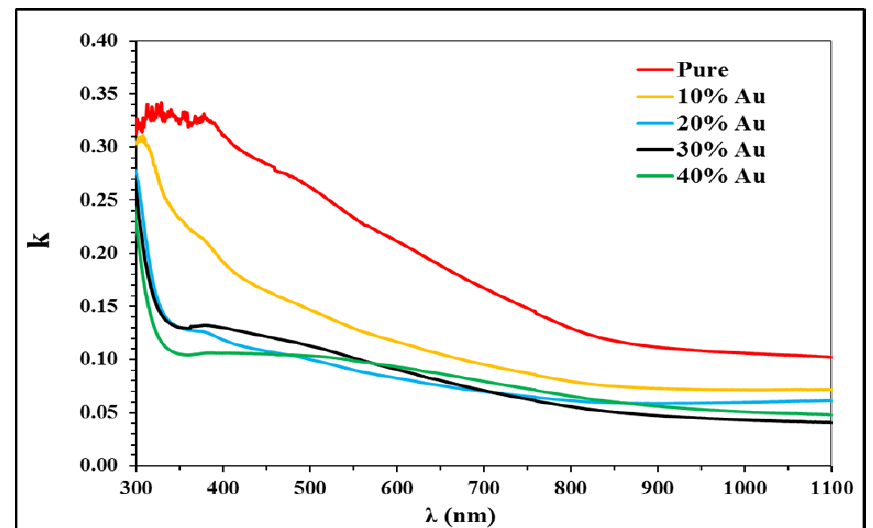
Fig. 12: The extinction coefficient for pure WO films as a function of wavelength at T